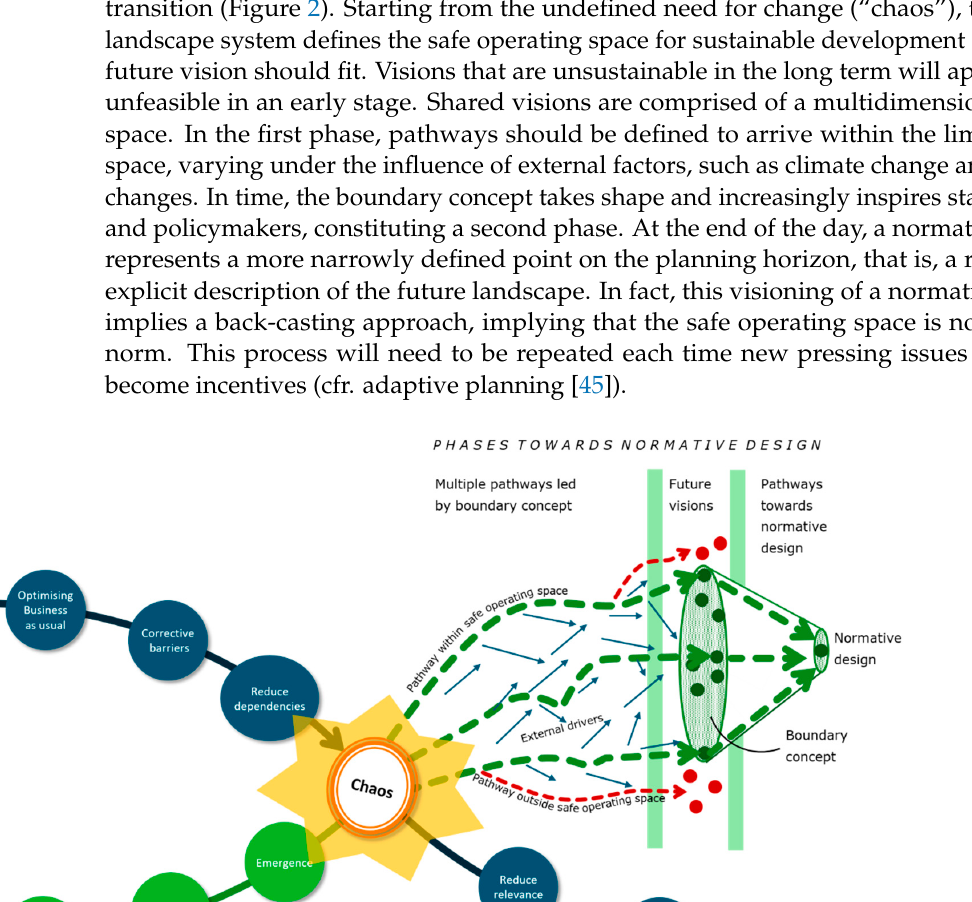
Table 1. Comparison of the examples.